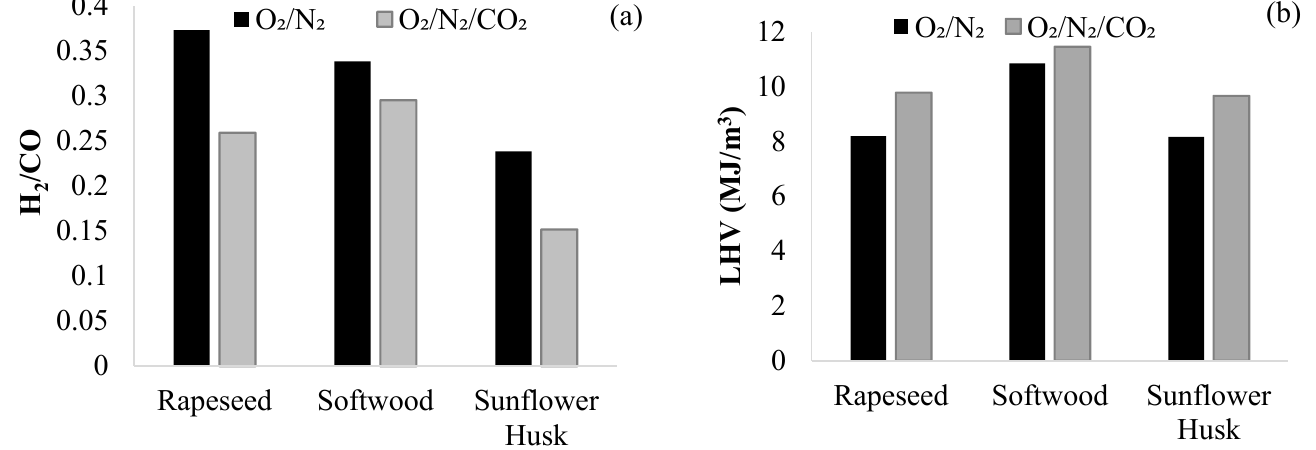
Figure 4. Effect of biomass and gasifying agent on ( a ) H 2 /CO ratio and ( b ) LHV. The H 2 /CO ratio obtained in the present experiment reduced with introducing CO 2 in the gasification atmosphere, due to the decreased H 2 and the increased CO